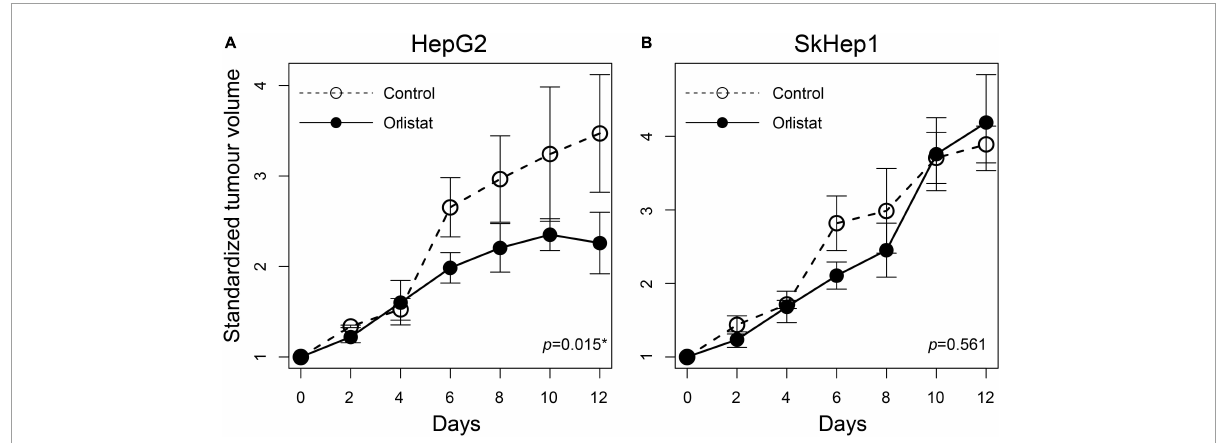
FIGURE6 Treatment response to orlistat in HCC xenografts assessed using tumor growth rates in nude mice. The tumor doubling time was significantly reduced in (A) orlistat-treated HepG2 xenograft mice compared with controls (* p = 0.015; n = 2 and 3 xenografts for control and orlistat treatment, respectively), whereas no significant difference was observed in (B) SkHep1 xenografts ( p = 0.561; n = 3 xenografts for each treatment). The open and solid circles are the averaged standardized tumor volumes for control and orlistat treatment, respectively. The averaged tumor volume as well as its error bar presenting the uncertainty ( ± 1 SD) was calculated from the replicates observed at different